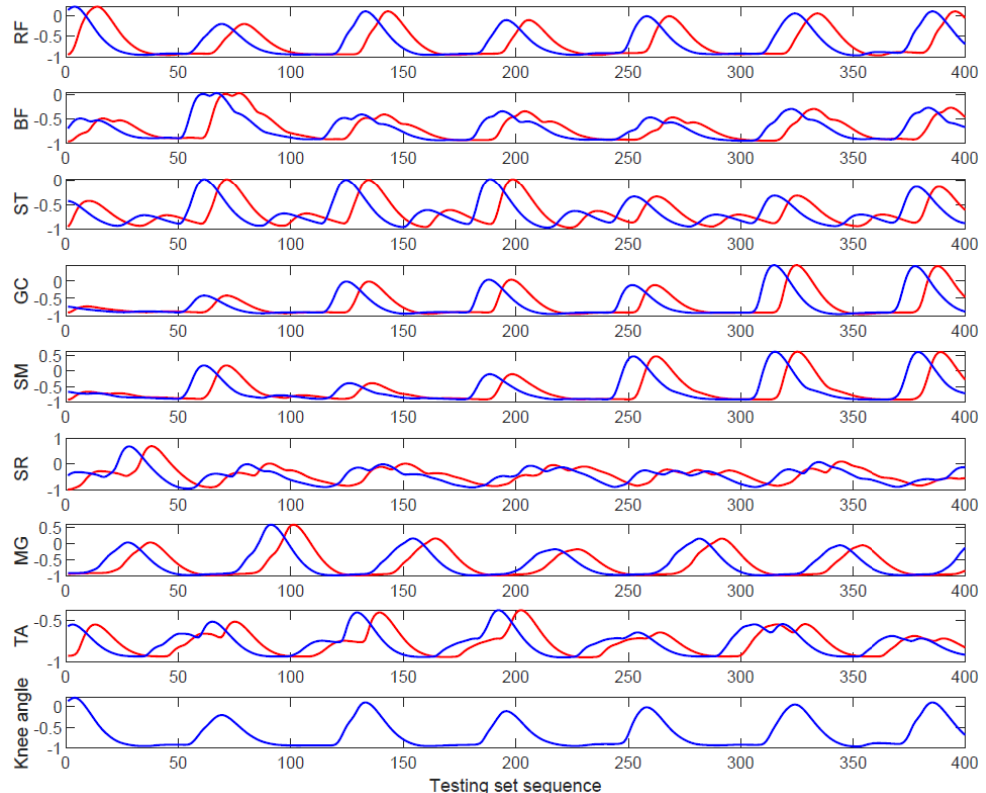
Figure 8. Curve of RRTAF (RMS and its time-advanced feature) of sEMG and curve of right knee joint angle after the normalization of subject 2. The blue line represents the RMS feature and the corresponding knee angle; the red line represents the time-advanced feature of RMS. Sensors 2019 , 19 , x FOR PEER REVIEW